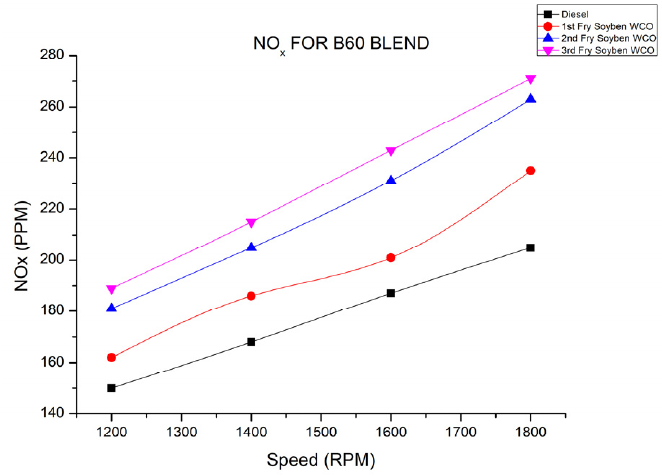
Figure 8. NOx emission of different fry oils (B60 blend) at different rpm.